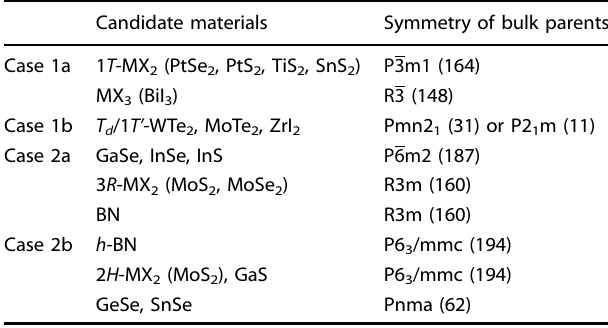
Table 2. Candidate bilayer materials and corresponding symmetries of bulk